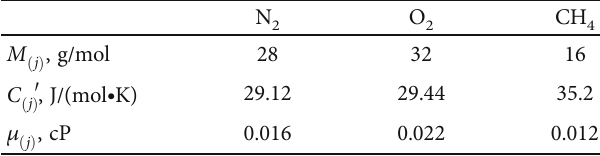
Table 7: Parameters of the ideal gas mixture.